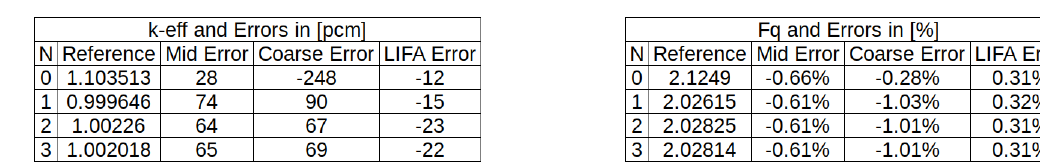
Table 1: 2D/1D k Results Table 2: 2D/1D Peaking Factor Results eff